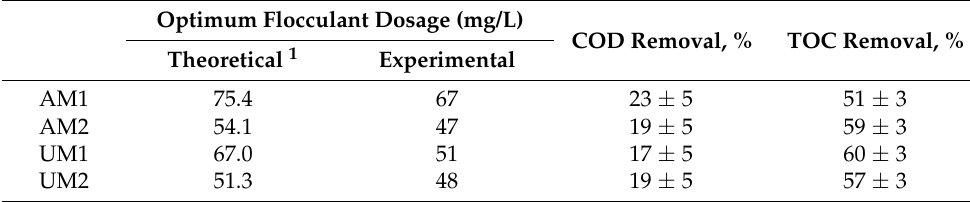
Table 5. Optimum flocculant dosages required to reach a zeta potential of 0 mV.